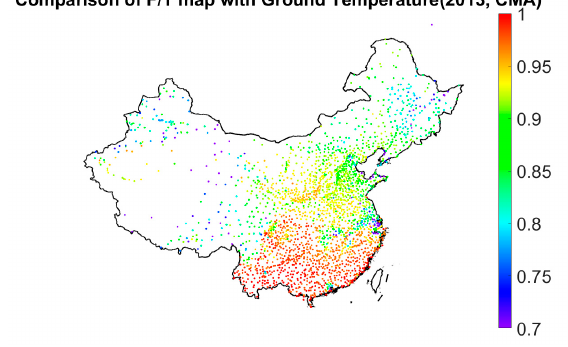
Figure 6. Accuracy assessment of F/T maps at individual meteorological stations in China.